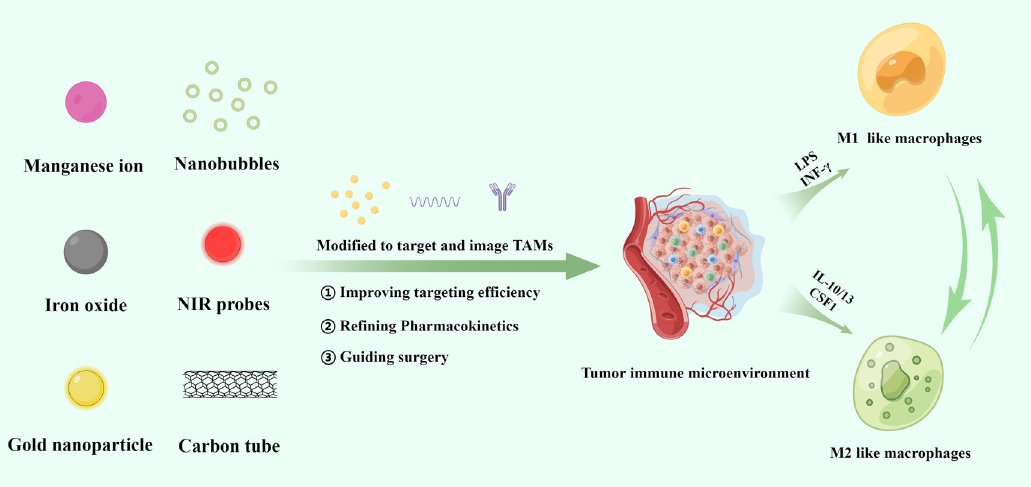
Figure 1. Schematic diagram of materials of tumor-associated macrophages targeting strategy.